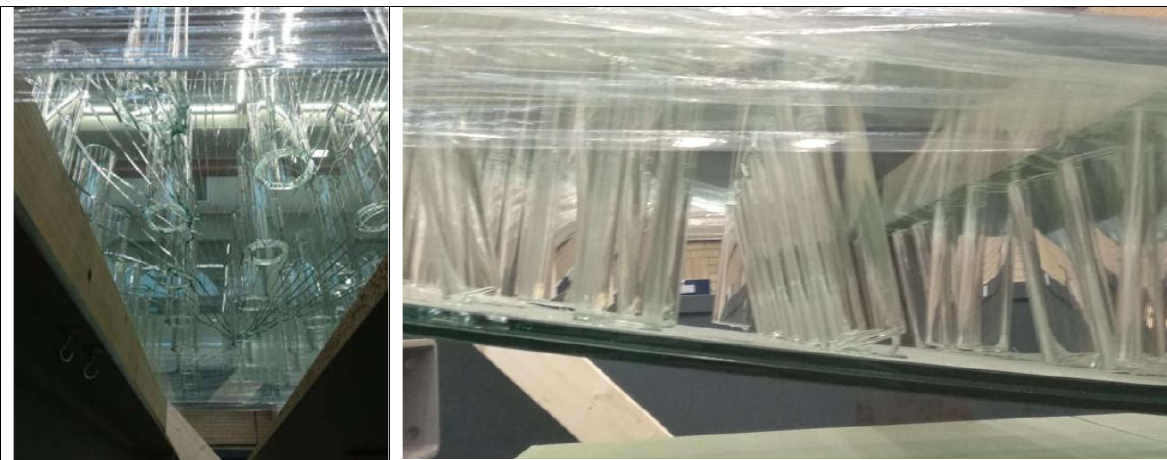
Fig. 20 Details of spacers at end of